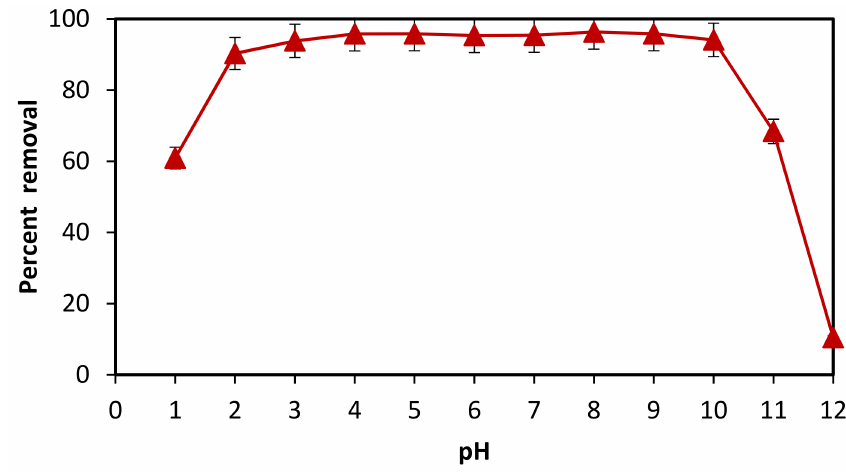
Figure 4. Effect of pH on percent removal of BG dye by F. benghalensis leaves